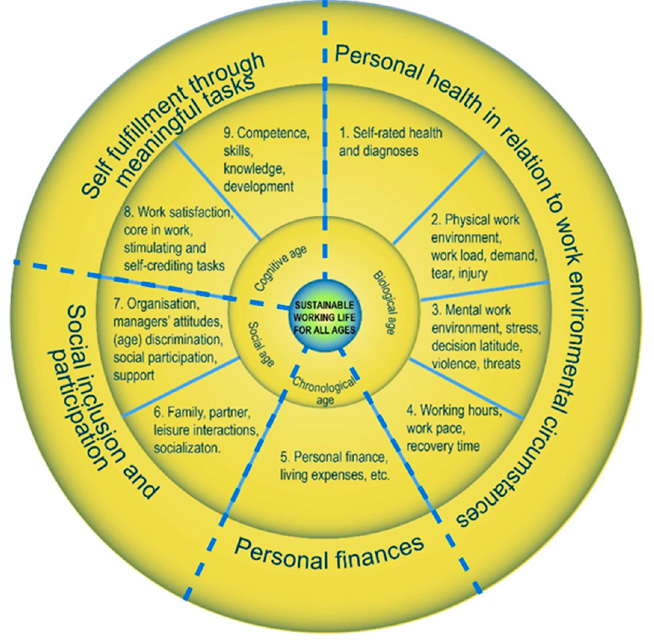
Figure A1. The micro level of the swAge TM -model—Sustainable working life for all ages. Available online: https://swage.org/en.html (accessed on 1 March 2021).